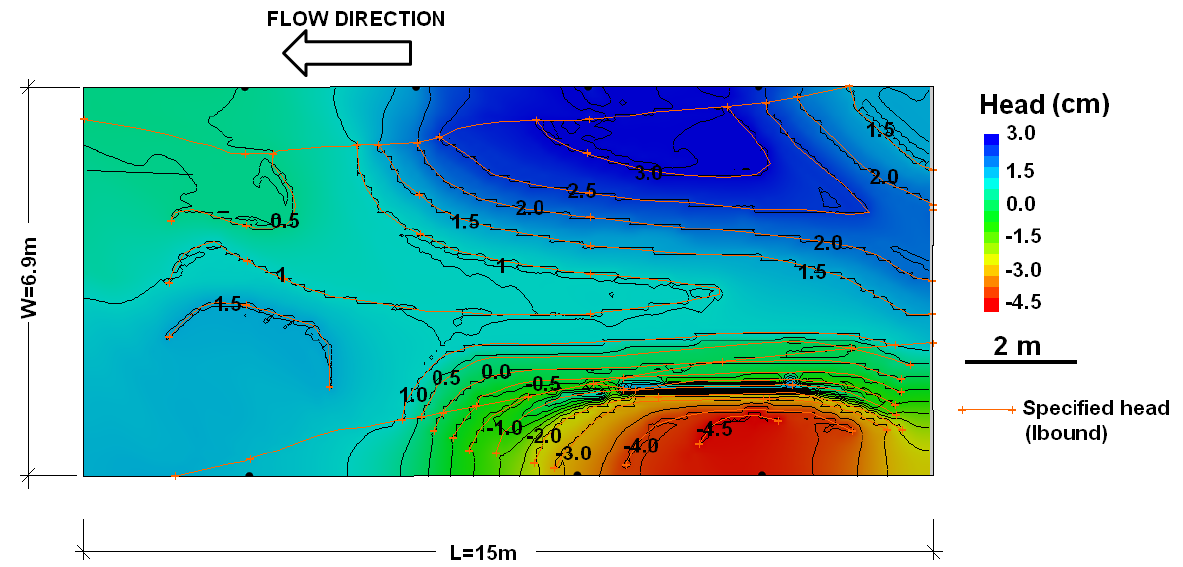
Figure 2. Head distribution in the 15 m-long reach of the Lachein stream measured by Malard et al. ’s [41] contour lines and reconstructed by FFT (color